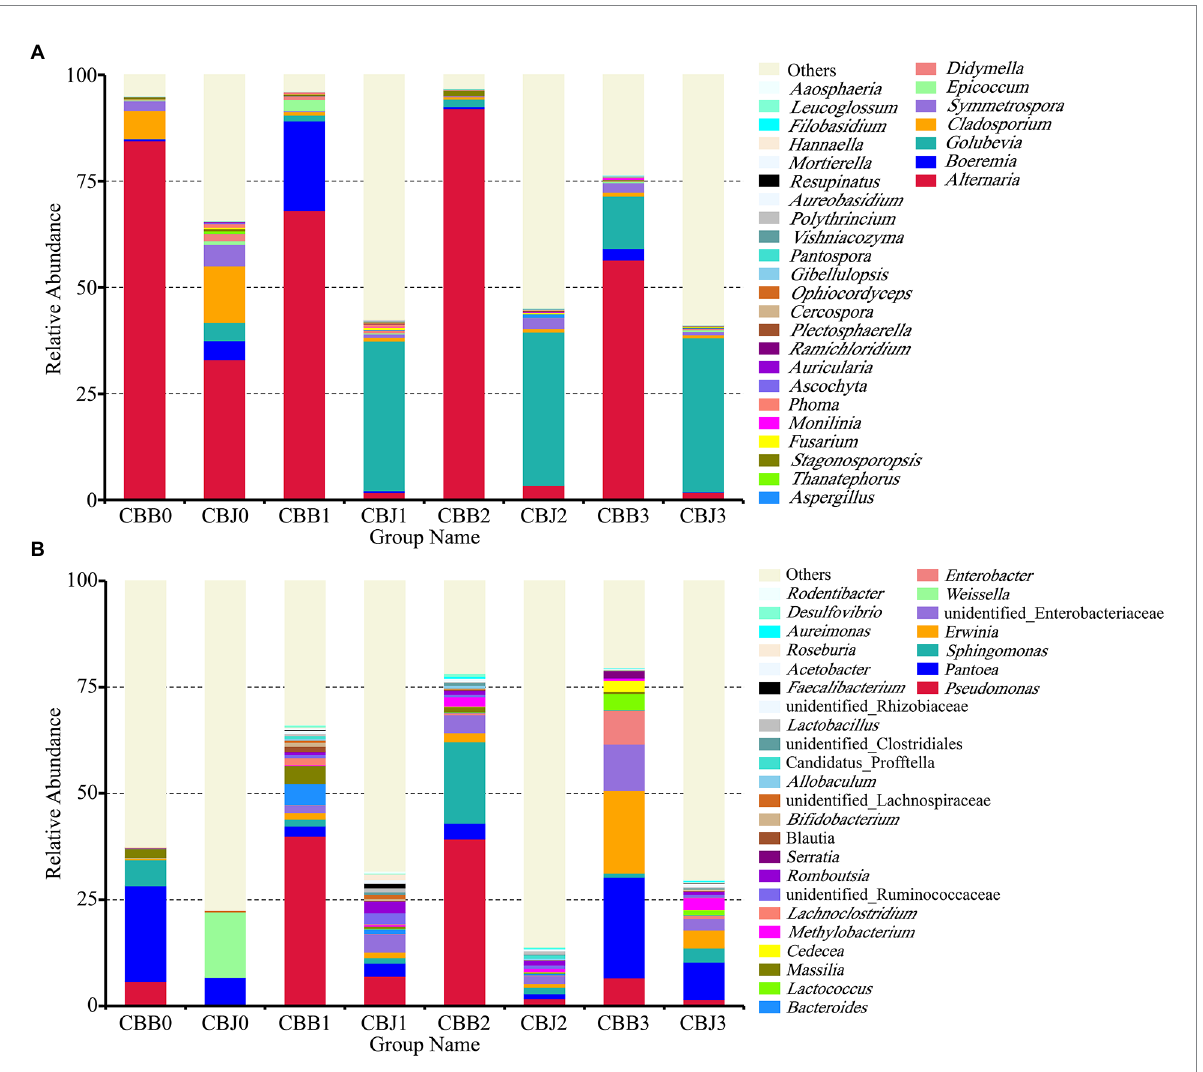
FIGURE 2 Microbial community composition of symptomatic (CBB) and asymptomatic (CBJ) tobacco leaves at four sampling time points (0–3) at the genus leaves ( A for fungi, B for bacteria). The genera with relative abundance less than 0.01% or without identification were classified as